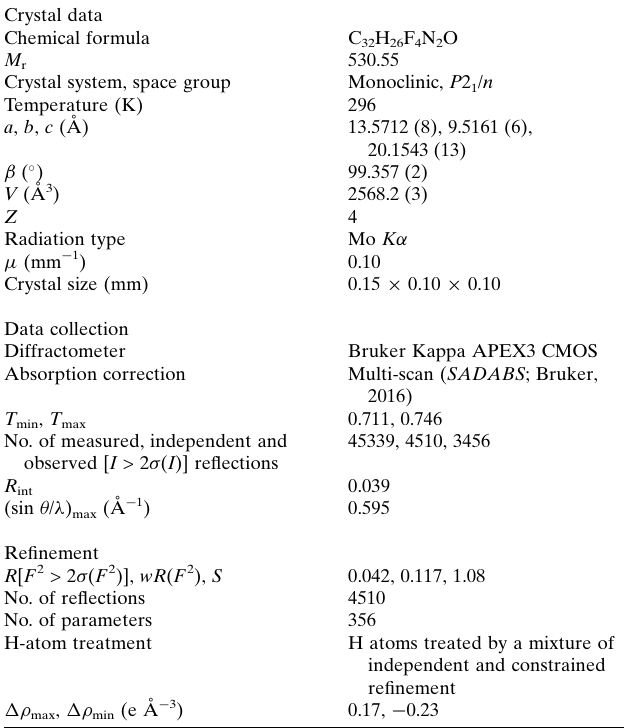
Table 2 Experimental